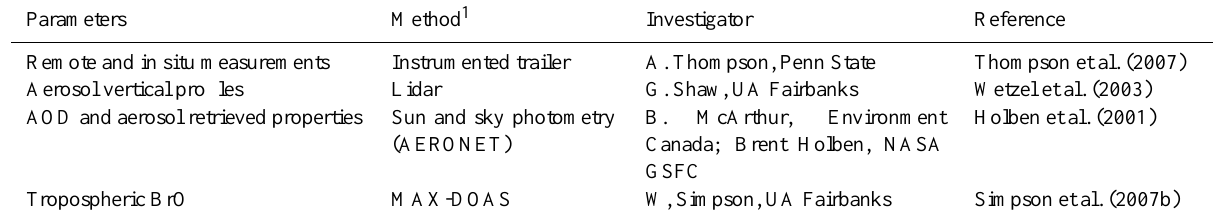
Table 3e. Ground-based investigations during